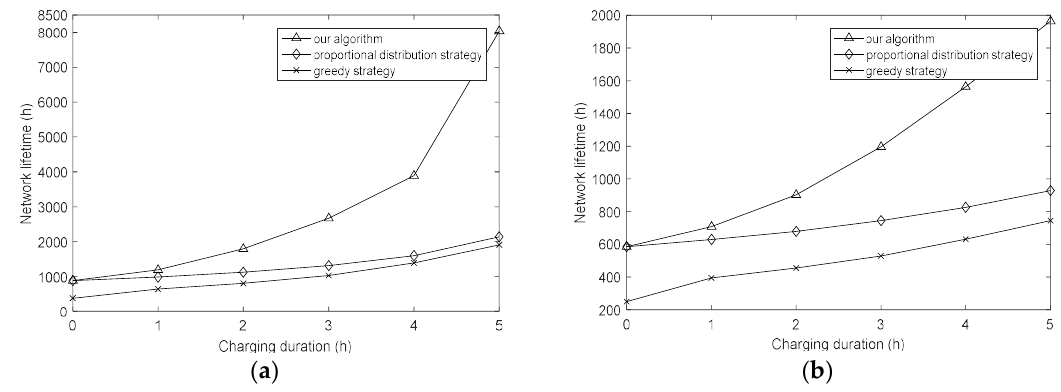
Figure 12. Network lifetime of different strategies with varying charging duration. ( a ) Packet size = 2000 bits; ( b ) packet size = 3000 bits.